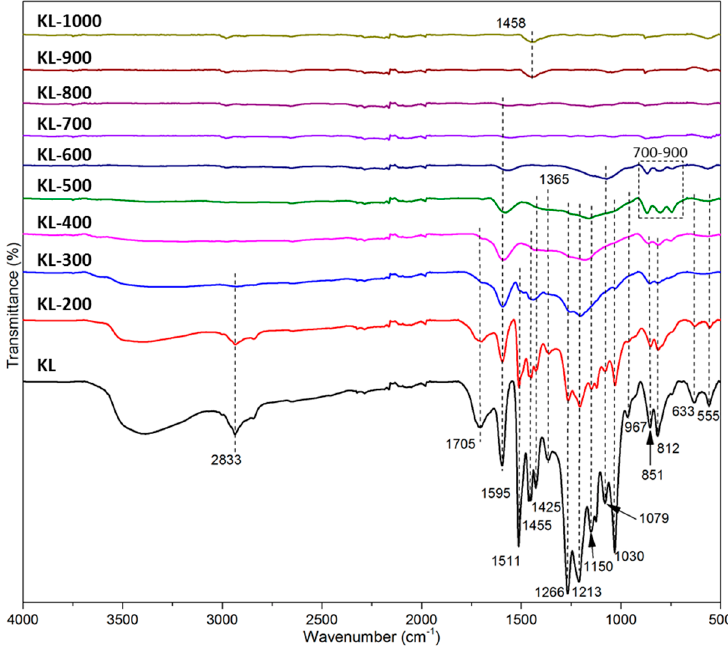
Figure 2. Fourier transform infrared (FTIR) spectra of KL-X samples.